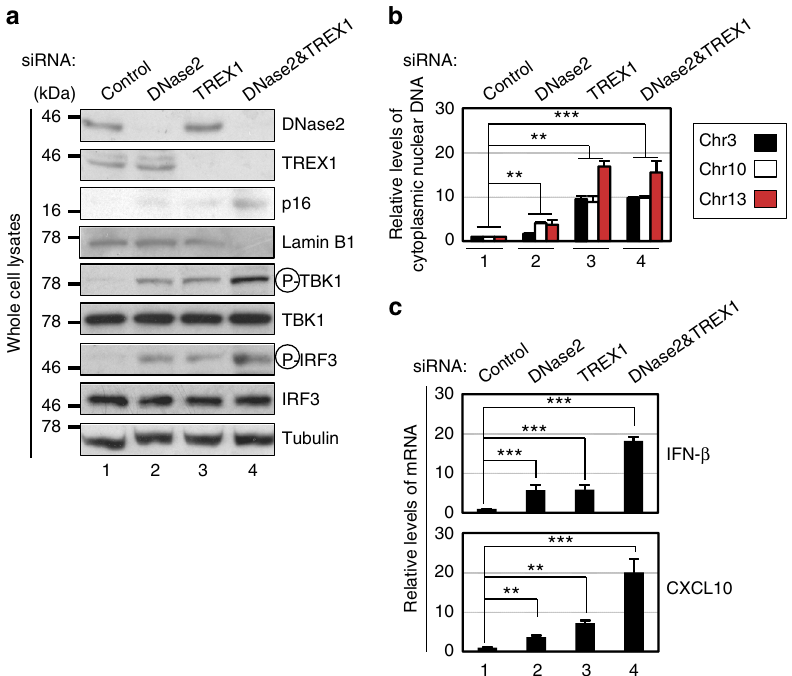
Fig. 4 The knockdown of cytoplasmic DNases activates the IFN- β pathway. a – c Pre-senescent TIG-3 cells were subjected to transfection with indicated siRNA oligos twice (at 2 day intervals). These cells were then subjected to western blotting using antibodies shown right ( a ), isolation of cytoplasmic fraction followed by qPCR analysis of chromosomal DNA ( b ) or qPCR analysis of SASP factor gene expression ( c ). Tubulin was used as a loading control ( a ). The representative data from three independent experiments are shown. For all graphs, error bars indicate mean ± standard deviation (s.d.) of triplicate measurements. (** P < 0.01. *** P < 0.001; one-way